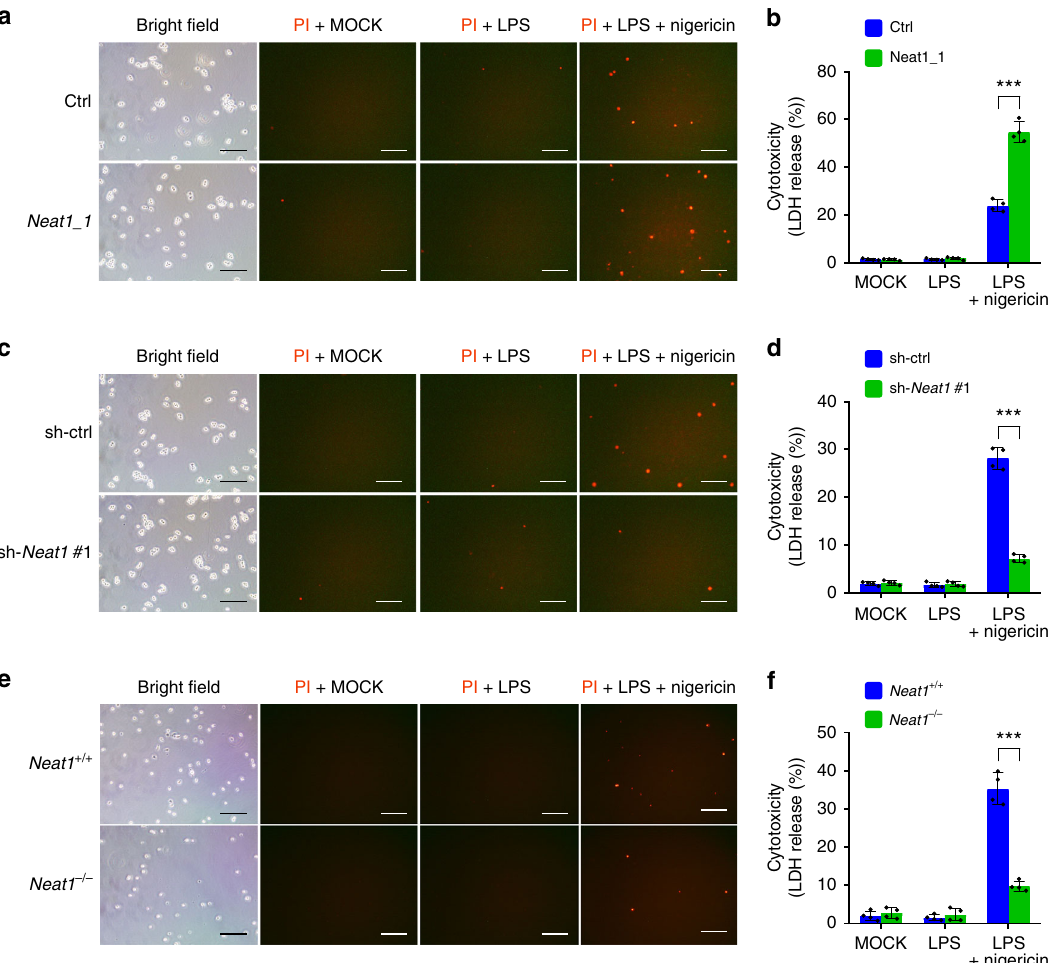
Fig. 6 Neat1 promotes caspase-1-dependent pyroptosis. a – f Neat1_1 -overexpressing iBMDMs ( a , b ), Neat1 -knockdown iBMDMs ( c , d ), Neat1 − / − BMDMs ( e , f ), and the corresponding control cells were primed with LPS and then stimulated with nigericin. Cells were stained with PI and analyzed under microscope ( a , c , and e ). Percentages of pyroptotic cells were measured by LDH release into supernatants ( b , d , and f ). In a , c , and e , the bar graph indicates 300 μ m. In b , d , and f , data shown are mean ± SD ( n = 4). *** P < 0.001, two-tailed t -test. Source data are provided as a Source Data fi